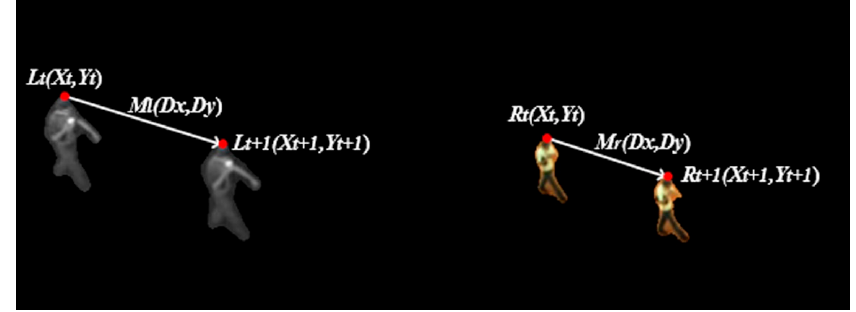
Figure 2. The relationships between the locations of the targets (red dots) and between the motion vectors of the targets (white lines).